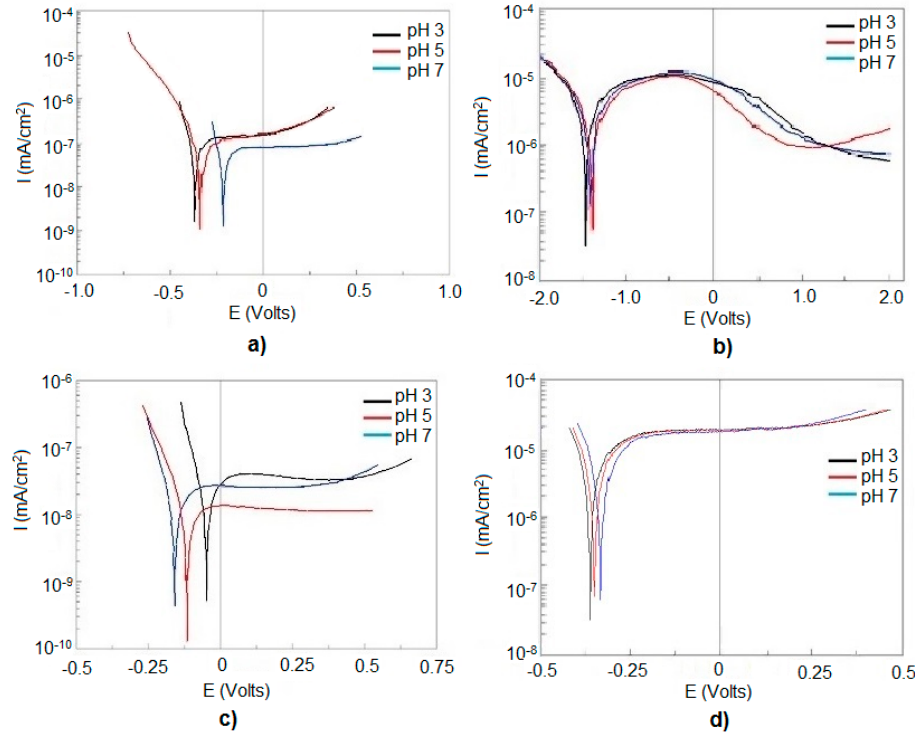
Figure 7. Potentiodynamic polarization curves at different pH. ( a ) Ti–13Nb–13Zr; ( b ) EO1 sample; ( c ) EO2 sample; ( d ) EO1 + EO2 sample.